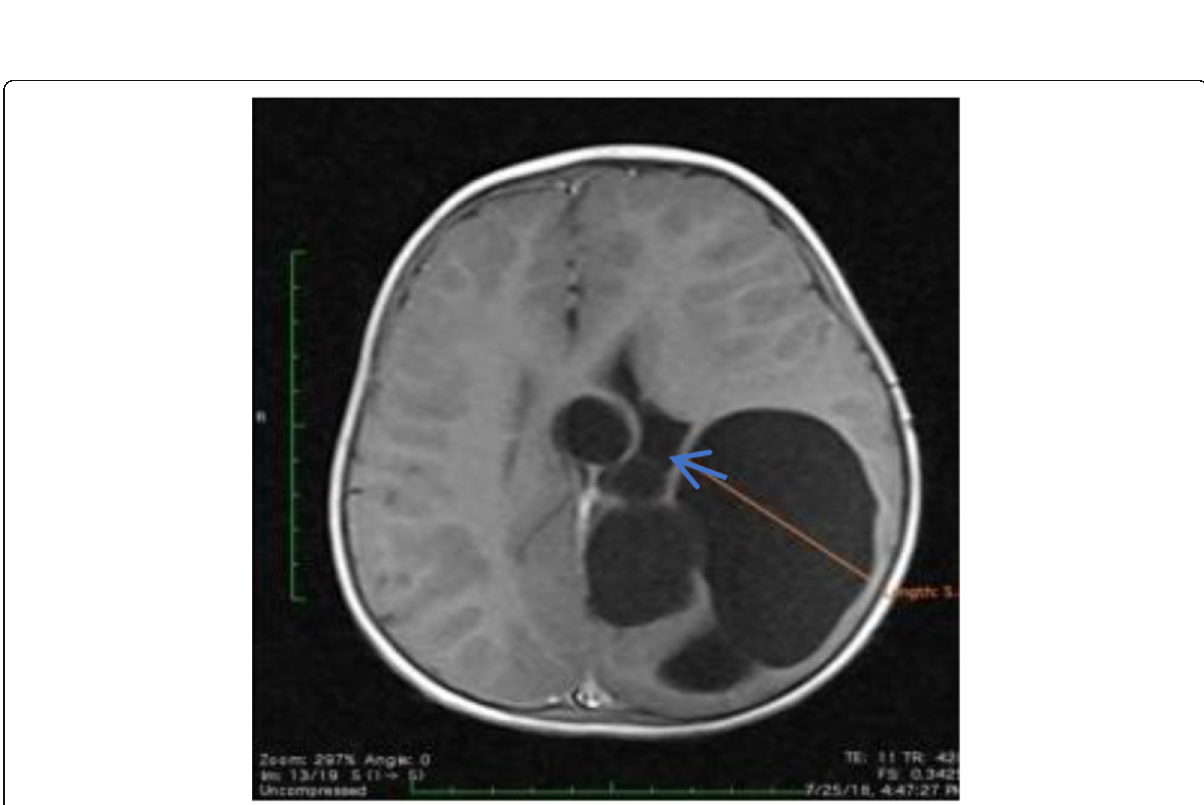
Fig. 4 MRI T1 axial sequence with an arrow showing the site of